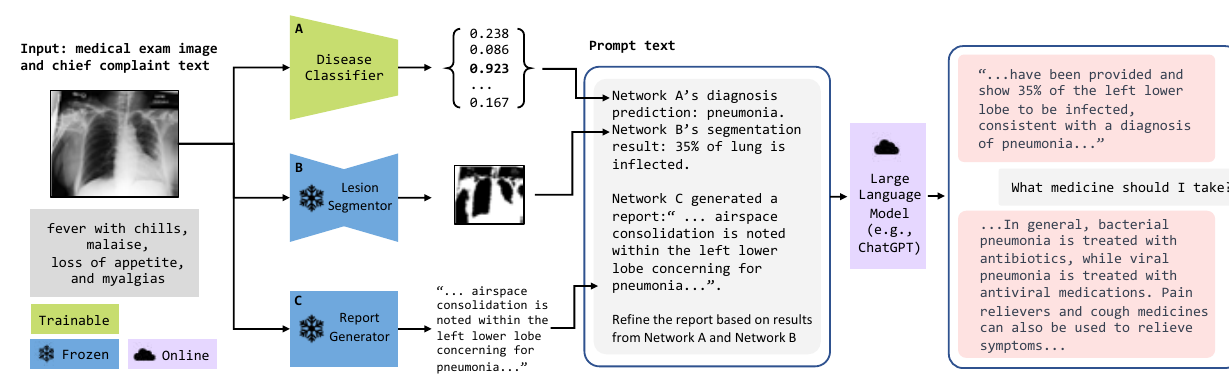
Figure 1. Overview of our proposed strategy. The image is processed by various networks to generate diverse outputs, which are then Figure 12 The stratrgies and mainly structure of ChatCAD, which leverages the medical domain knowledge combining the logical reasoning skills of transformed into text descriptions. The descriptions, served as a link between visual and linguistic information, are combined as inputs to LLMs and the computer vision comprehension competence of existing medical image CAD model to assist doctors having a all-round understanding of a large language model (LLM). With its ability to reason and its knowledge of medical field, the LLM can provide a condensed report and symptoms and improve diagnostic process along with better therapeutic effectiveness [32]. offer interactive explanations and medical recommendations based on the given